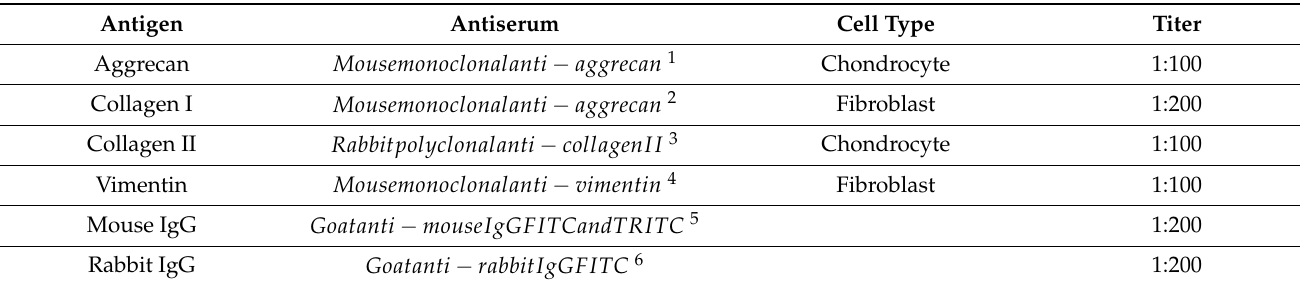
Table 1. List of antibodies applied for the